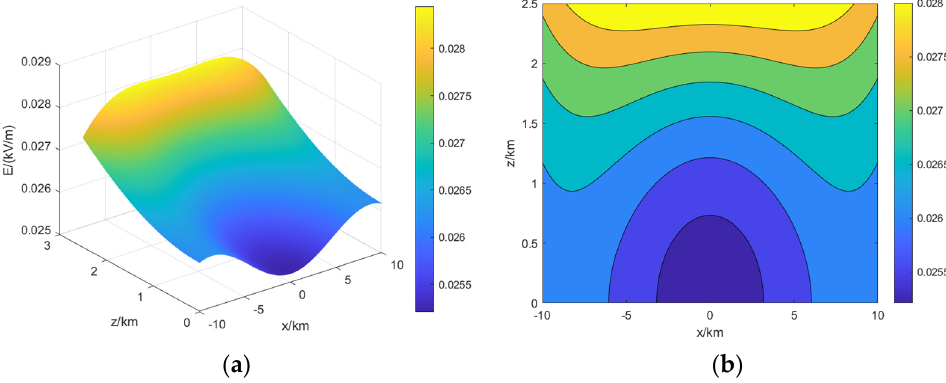
Figure 9. ( a ) Electric field distribution on the longitudinal section while y = 22 km. ( b ) Contour of potential distribution on the longitudinal section while y = 22 km.